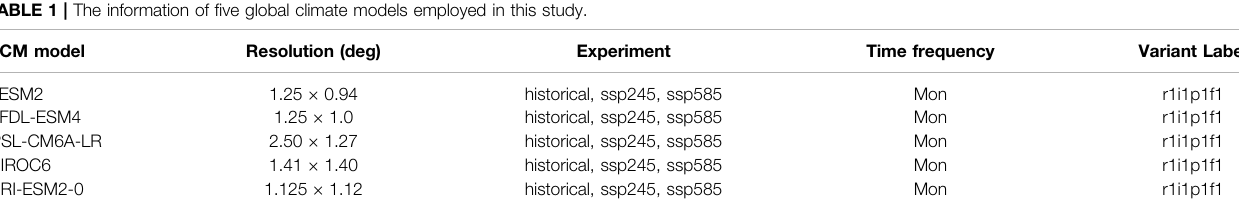
TABLE 1 | The information of fi ve global climate models employed in this study.